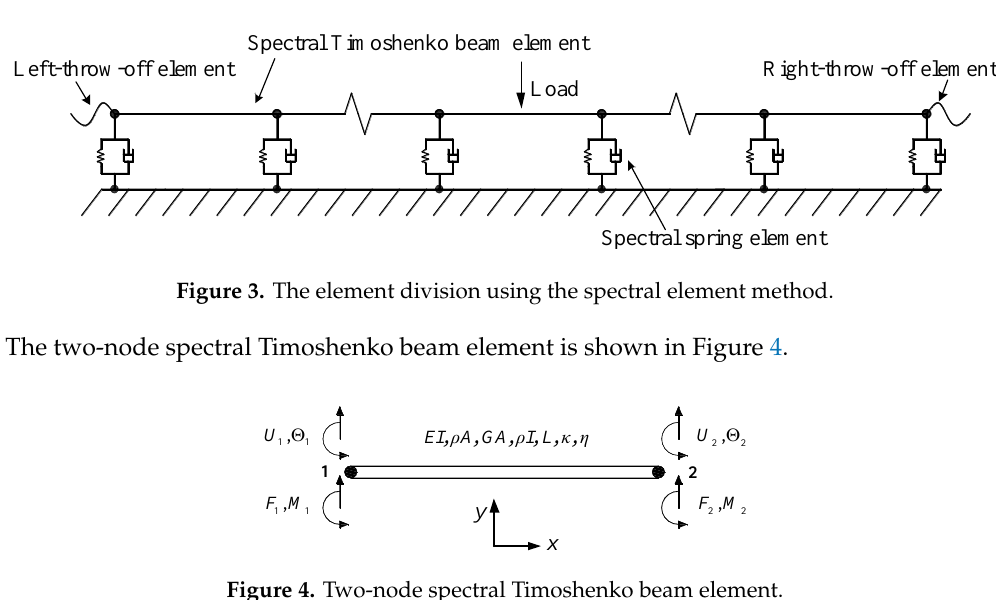
Figure 4. Two-node spectral Timoshenko beam element.